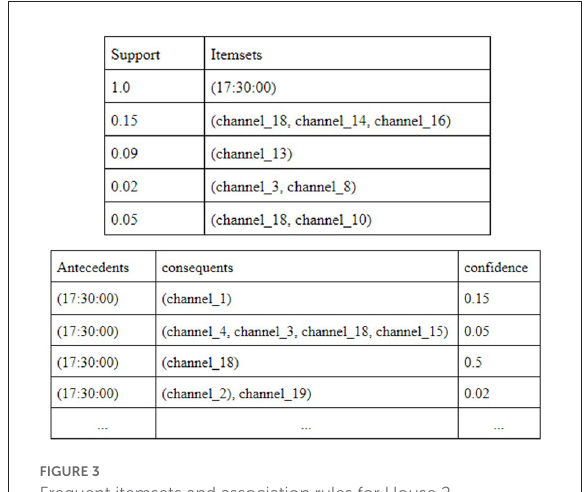
FIGURE3 Frequent itemsets and association rules for House